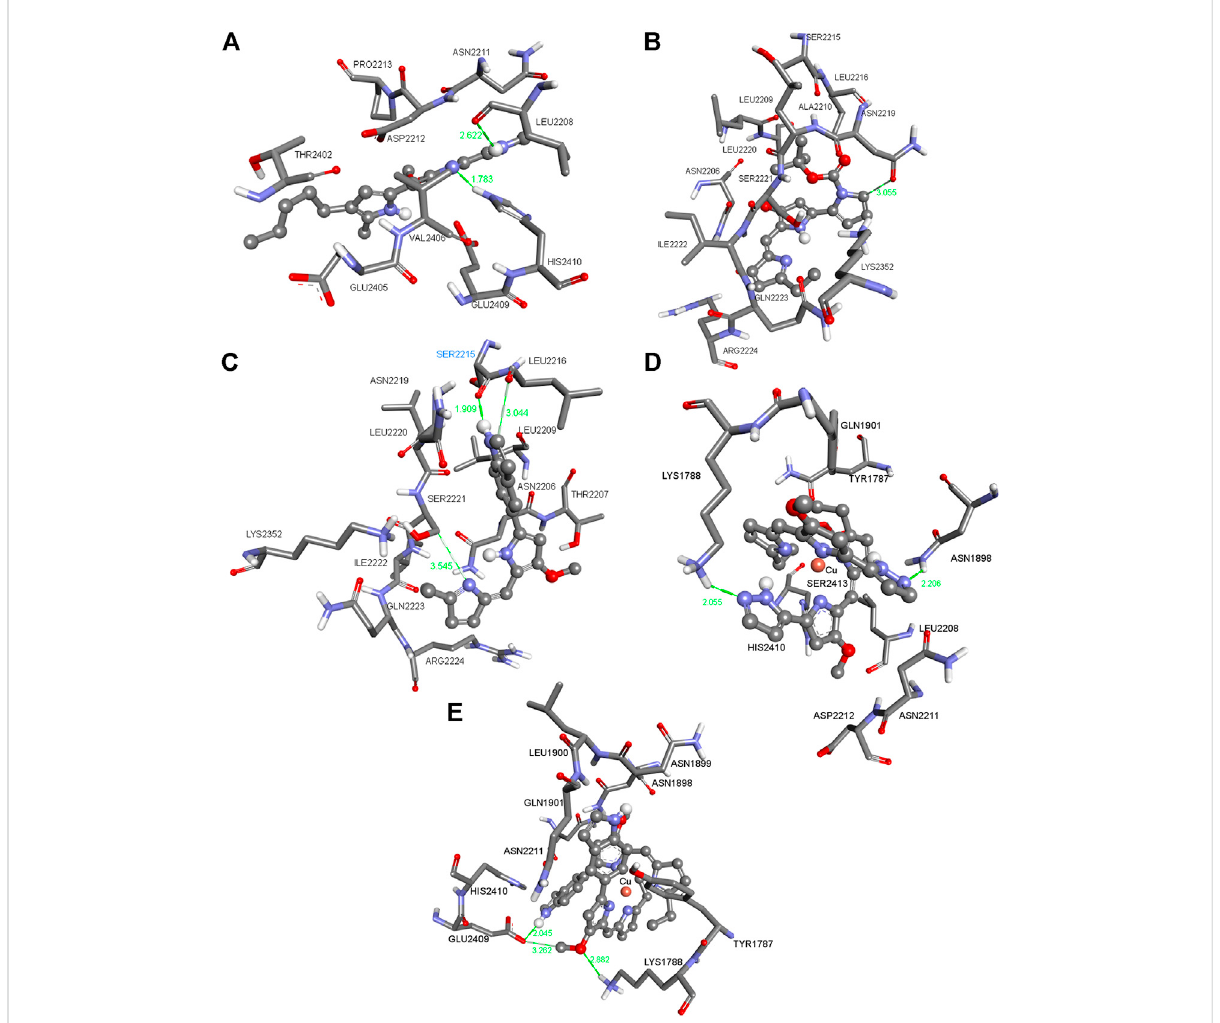
FIGURE 2 Three-dimensional(3D)imageswiththedisplayedhydrogenbondingdistances(ingreen)generated via moleculardockingof (A) Ps , (B) ligands L 7 (C) and L 14 and copper(I) complexes (D) C9 and (E) C14 into mTOR enzyme. Amino acid side chains are shown as sticks, the ligands as ball and sticks, and the chelating atom coppers are depicted as round copper